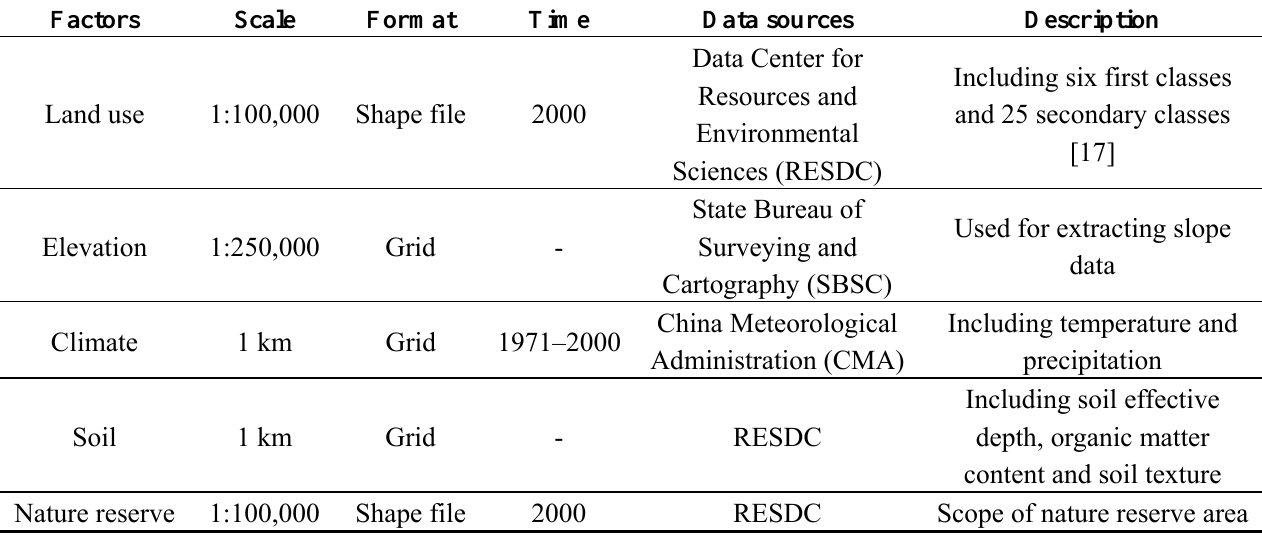
Table 1. General description of the research data.